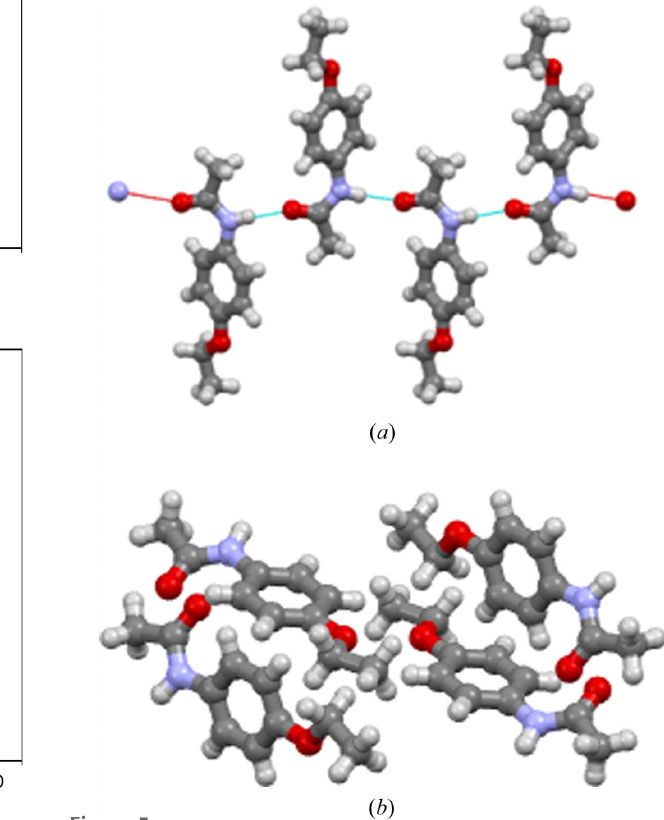
Figure 4 Relationships between ( a ) nucleation rates J and supersaturation S ; ( b ) ln( J / S ) and 1/(ln 2 S ) according to classic nucleation theory.